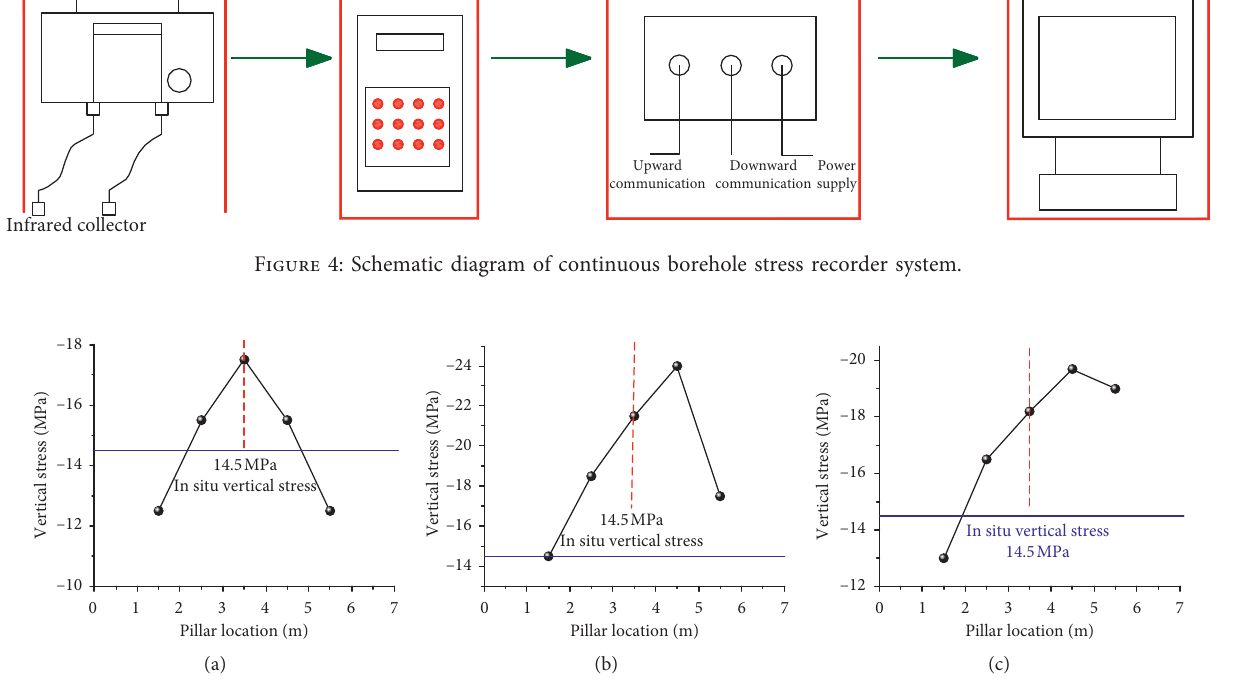
Figure 5: Abutment load profiles with different distance to the panel 15201 longwall face (negative and positive numbers indicate the 15201 longwall face was inby and outby the site, respectively). (a) Stage A, − 10m. (b) Stage B, +80m. (c) Stage C, +150